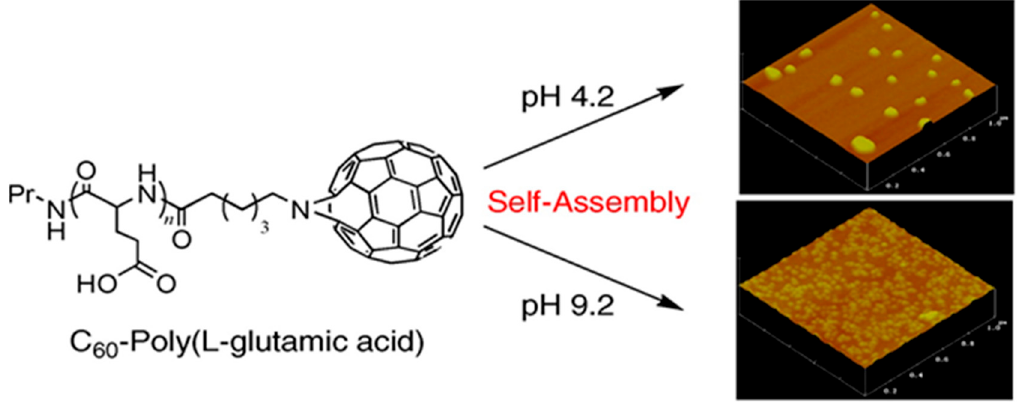
Figure 11. Illustration of fullerene-tagged poly(glutamic acid) and its pH-responsive self-assembling behavior. Reproduced with permission from [179]. Copyright 2006, Elsevier.